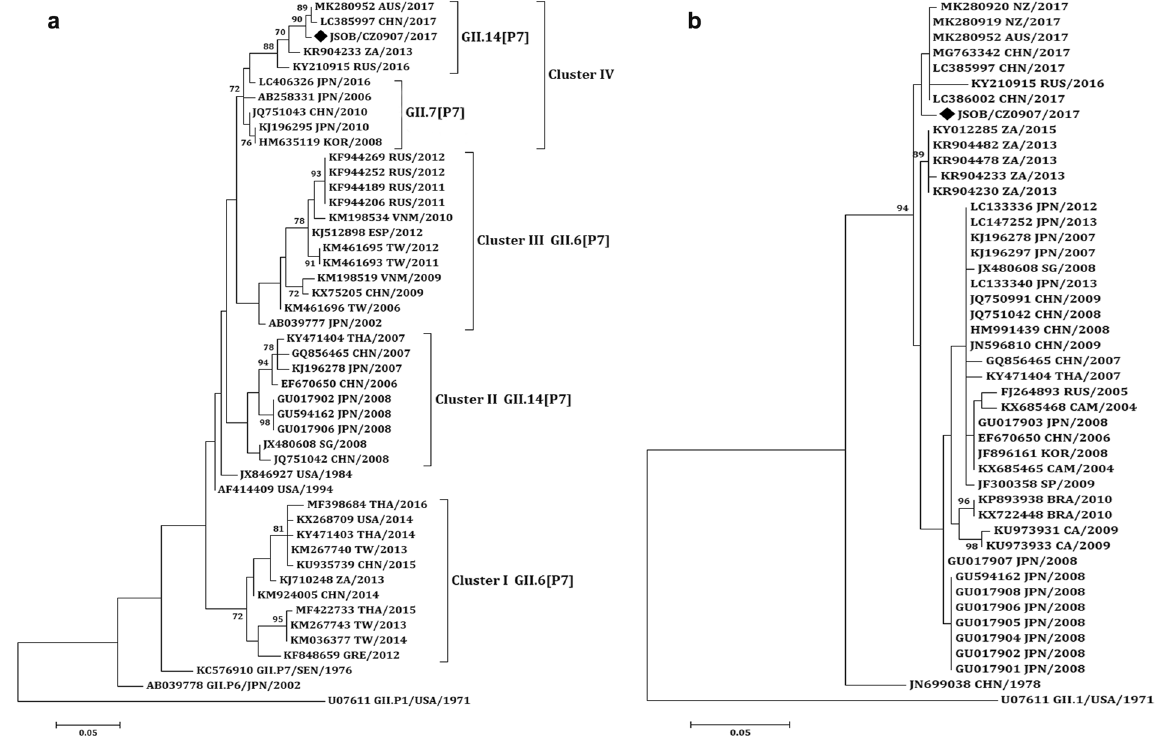
Figure 5. Phylogenetic analyses of the GII.14[P7] sequences based on partial RdRp and VP1. ( a ) Phylogenetic tree of a 313 bp region of RdRp. ( b ) Phylogenetic tree of a 282 bp region of VP1. The trees were constructed using the Maximum Likelihood analysis and the evolutionary distances were computed using the Kimura 2-parameterþG method available in MEGA 7.0. Bootstrap values ( > 70%) are shown as percentages derived from 1,000 samplings at the nodes of the tree. The scale bars represent the number of nucleotide substitutions per site. The new norovirus strains reported in this study are indicated with solid black diamond.